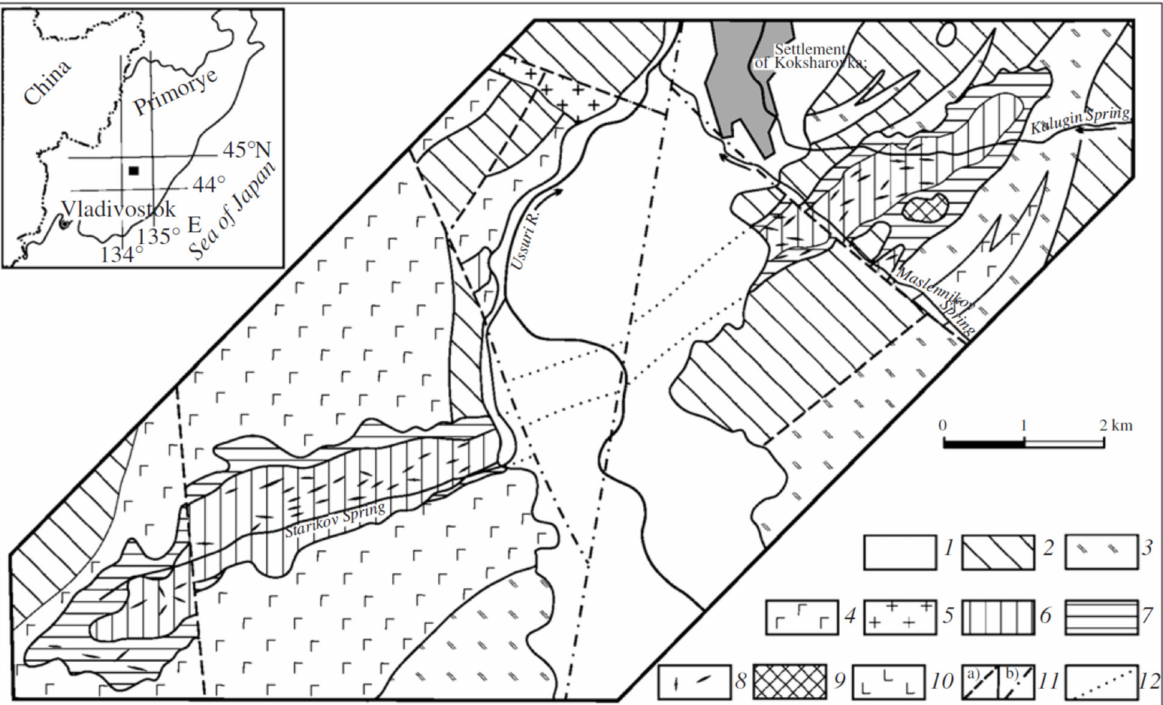
Figure 8. Geological map of the Koksharovka alkaline ultrabasic massif (after [29,36,38]). (1) Stream sediments; (2–4) Triassic Jurassic siliceous–terrigenous–volcanic rock complex (matrix of the accre- tionary wedge) with lenses and beds of siliceous (3) and volcanic (4) rocks: basalt lavas and tuffs; (5) Late Cretaceous granite; (6–9), alkaline ultrabasic complex: biotite-bearing pyroxenite (6), amphibole- bearing pyroxenite (7), syenite dike (8) and carbonatite (9); (10) diabase and gabbro-diabase; (11) proven (a) and supposed (b) faults; (12) contours of the pyroxenite body beneath the alluvial deposits inferred from geophysical